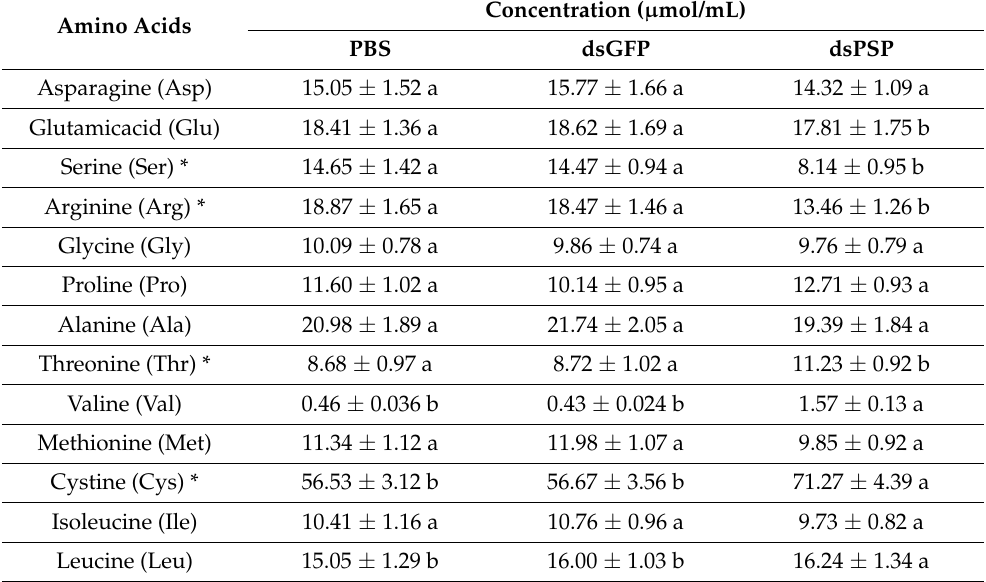
Figure 6. Knockdown of PSP via dsPSP injection treatments ( A ) reduced PSP enzyme activity ( B ) and the expression level between dsGFP-treated controls and dsPSP. The histogram bars show mean values (n = 3), and the error bars indicate means ± SEM. Histogram bars annotated with different lowercase letters are significantly different at p < 0.05 (Student’s t -test); DAE is days after emergence. Table 1. Adult C. lividipennis female hemolymph’s free amino acids contents under different injection treatments of the same volume of PBS, dsGFP, and dsPSP for 2